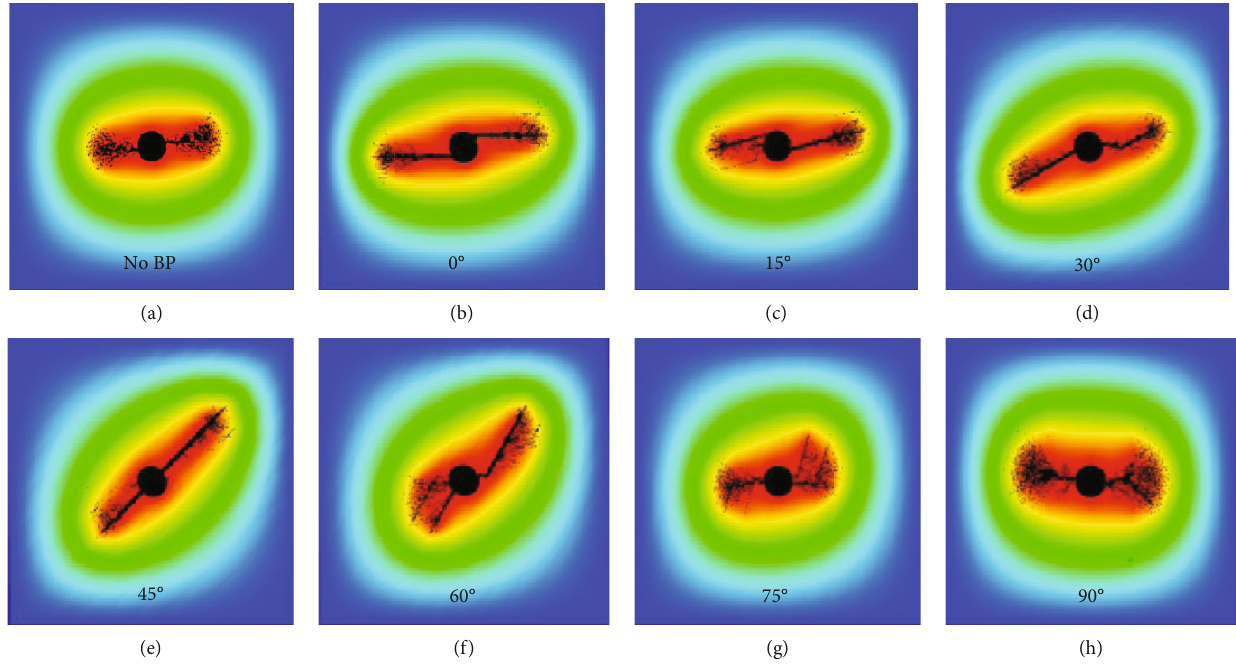
Figure 13: HF morphologies under di ff erent BP angles; BP spacing is 0.10